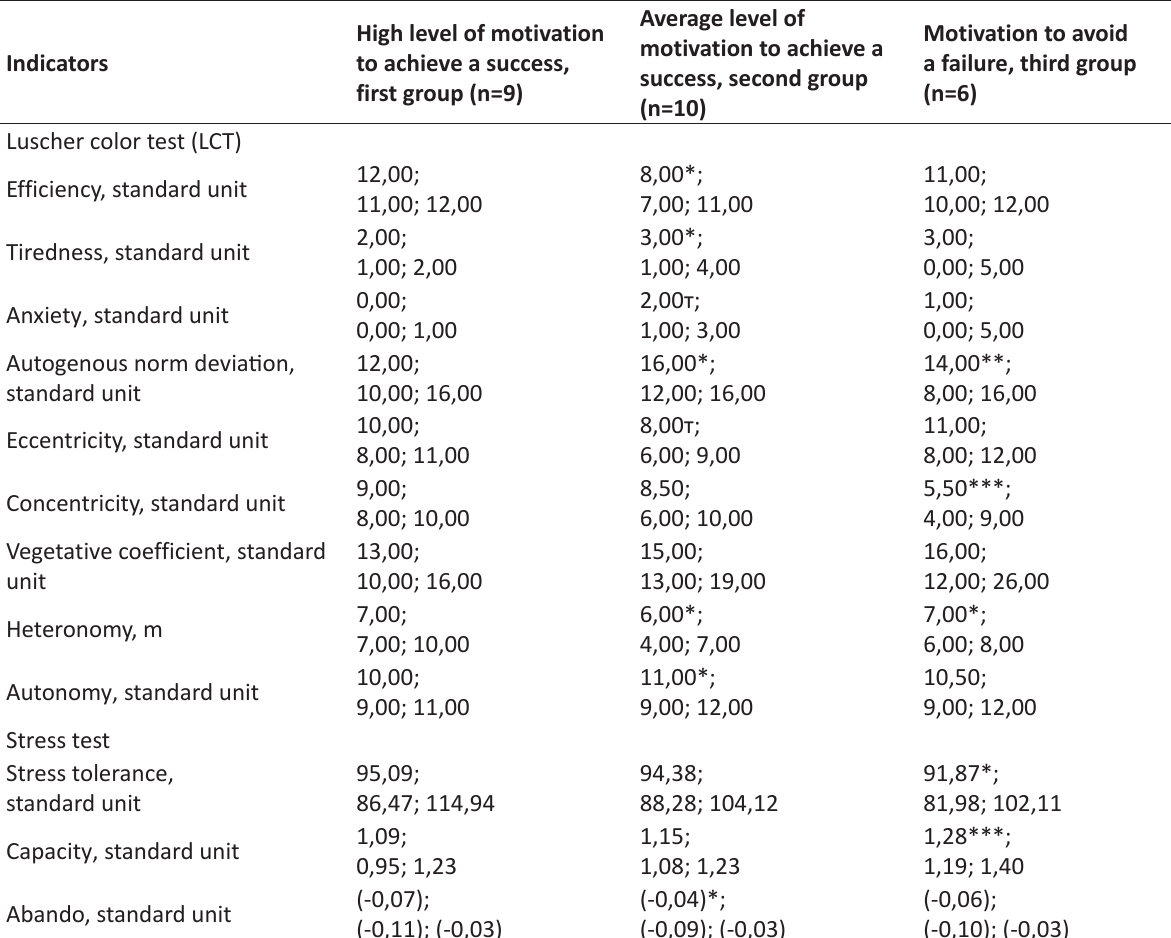
Table 3. The mental state of high qualification judo athletes with different levels of motivation (median, lower quartile, upper